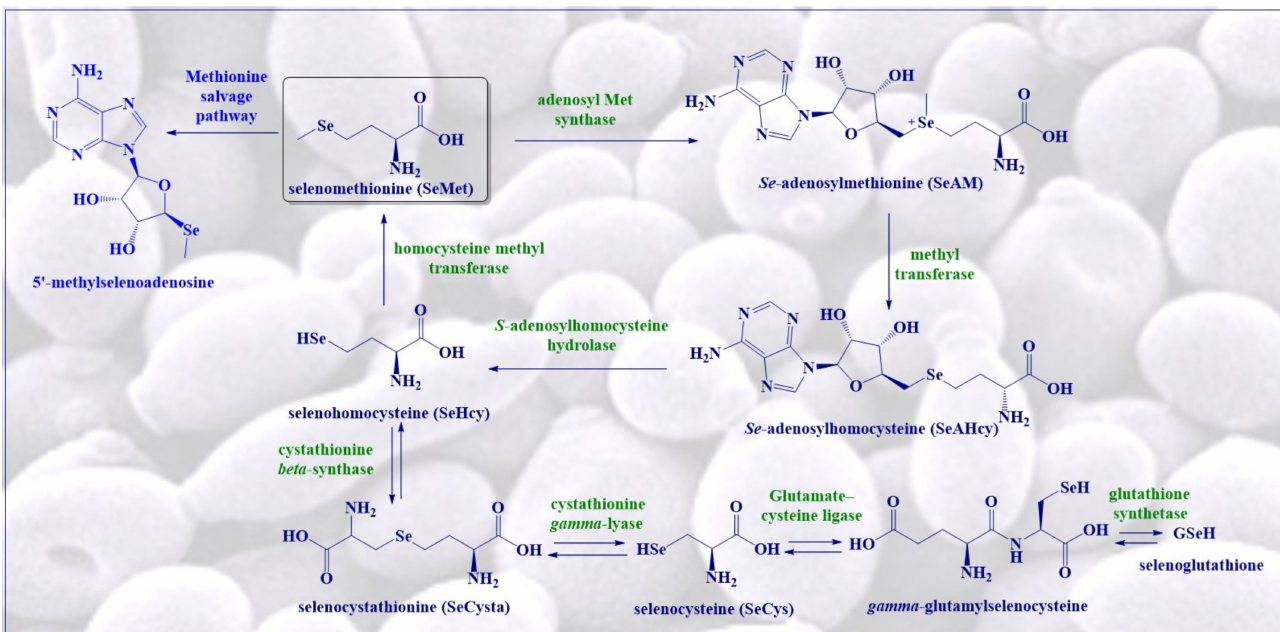
Figure 2. Structures of some of the metabolites of SeMet found in selenium-enriched